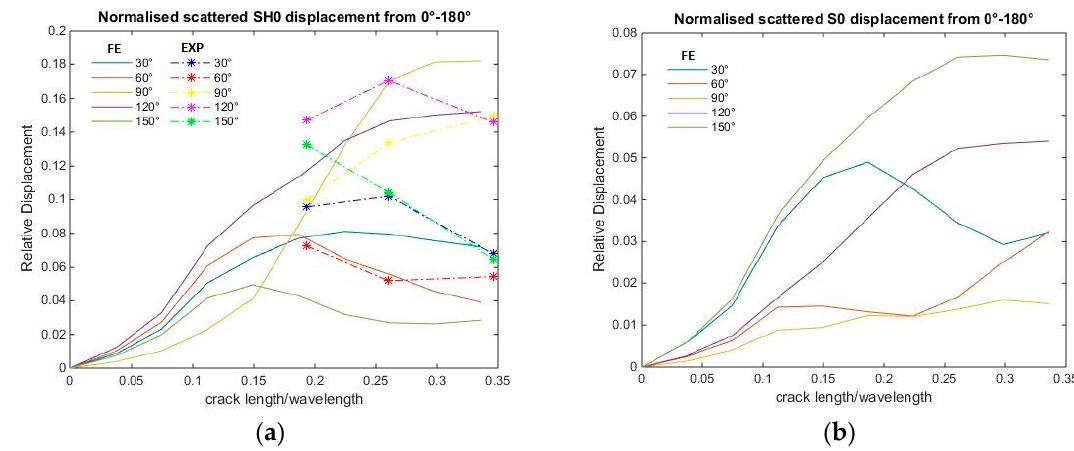
Figure 11 . ( a ) FE and experimental results: normalised scattered SH0 wave displacement for various